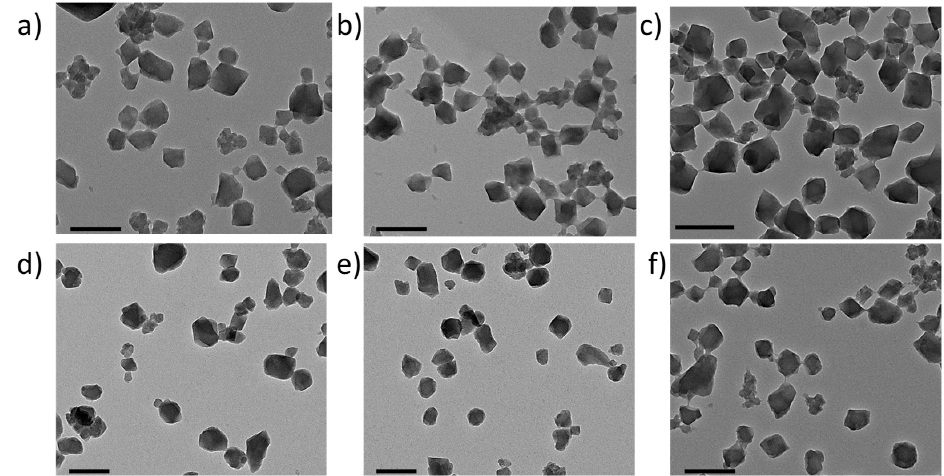
Figure 1. TEM images of nanosized metal-organic frameworks (nanoMOFs) before and after coating